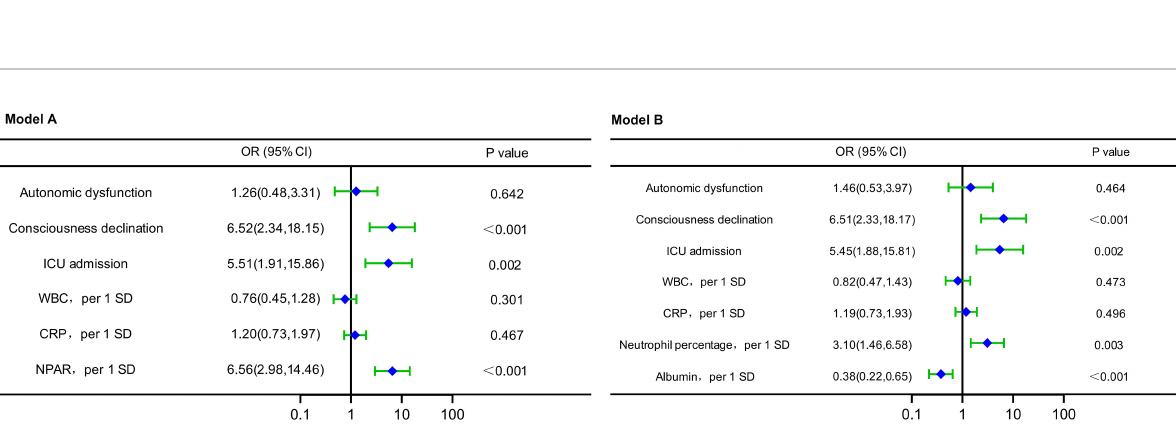
FIGURE 4 | Forest plots of multivariable logistic regression affecting disease severity at admission (Model A and Model B). OR, odds ratio; CI, con fi dence interval; ICU, intense care unit; WBC, count of white blood cell; SD, standard deviation; CRP, C-reactive protein; NPAR, neutrophil percentage-to-albumin